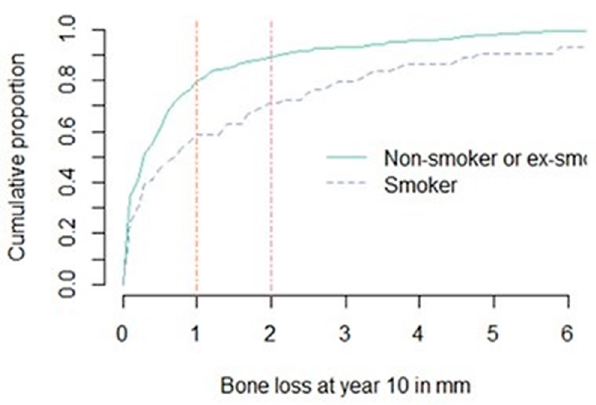
Figure 4. Cumulative percentage of individual peri-implant bone loss, smokers compared to non-smokers.